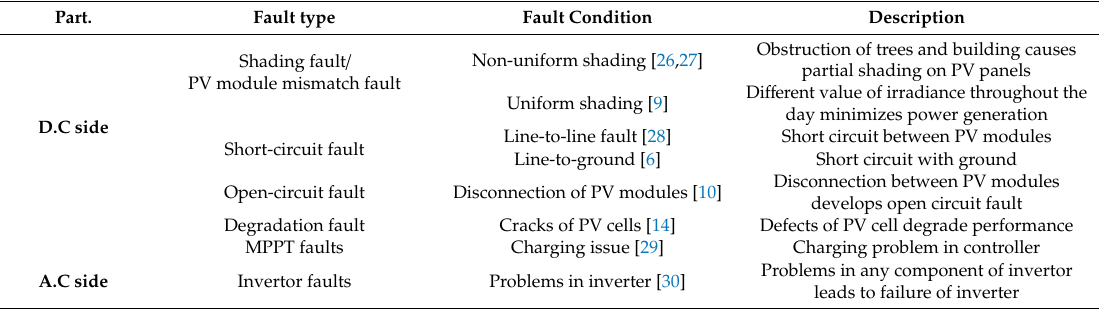
Table 2. Classification of PV